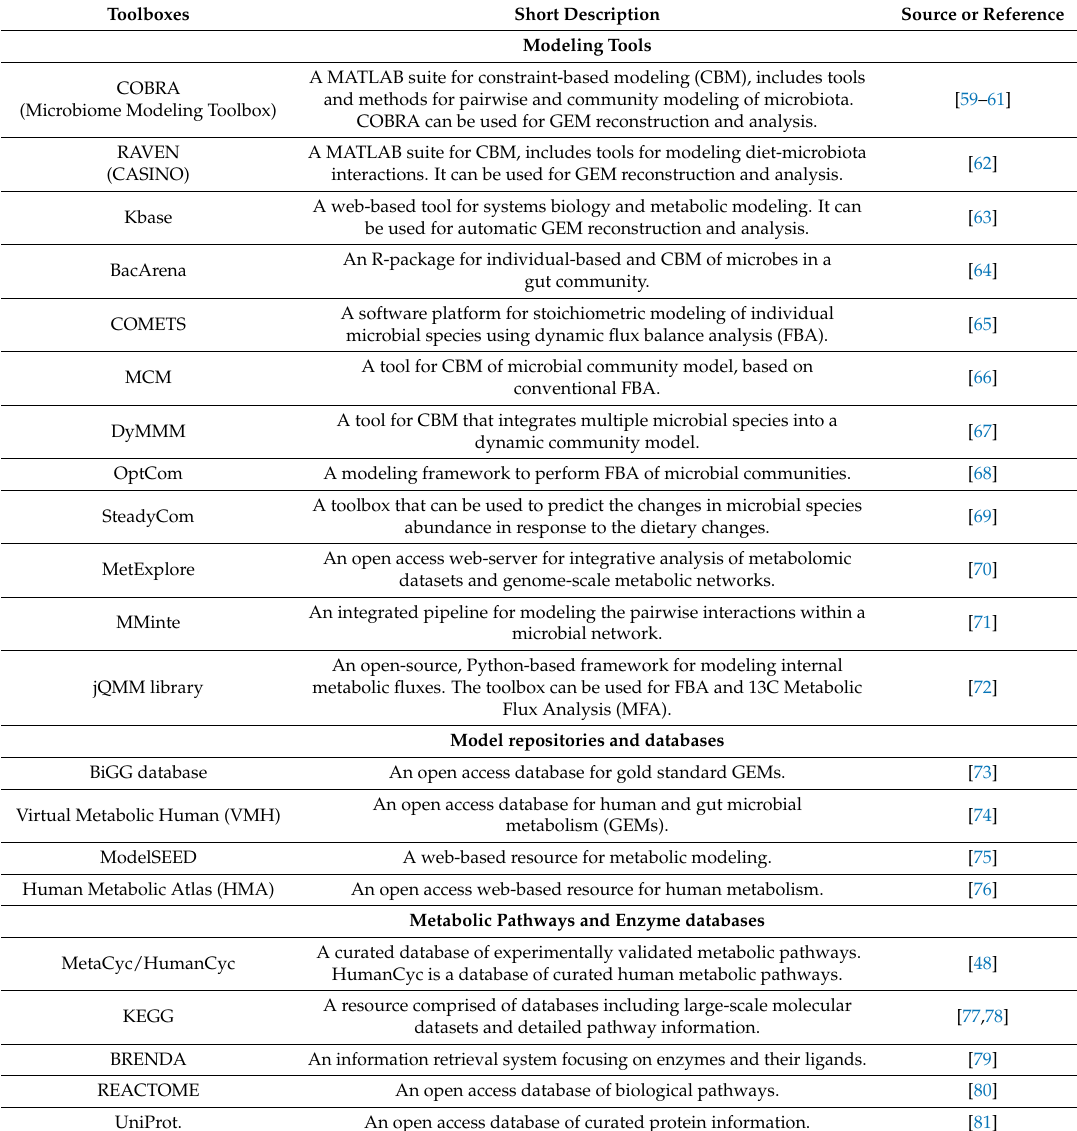
Table 1. Tools and resources for genome-scale metabolic